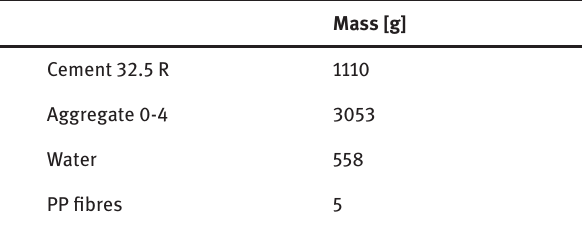
Figure 2 : Experimental setup of DCSBD for the treatment of PP fibres (The pusher is not shown on the picture for the sake of clarity). Table 1: Composition of